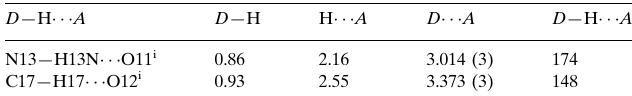
Hydrogen-bond geometry (A˚ , (cid:1)